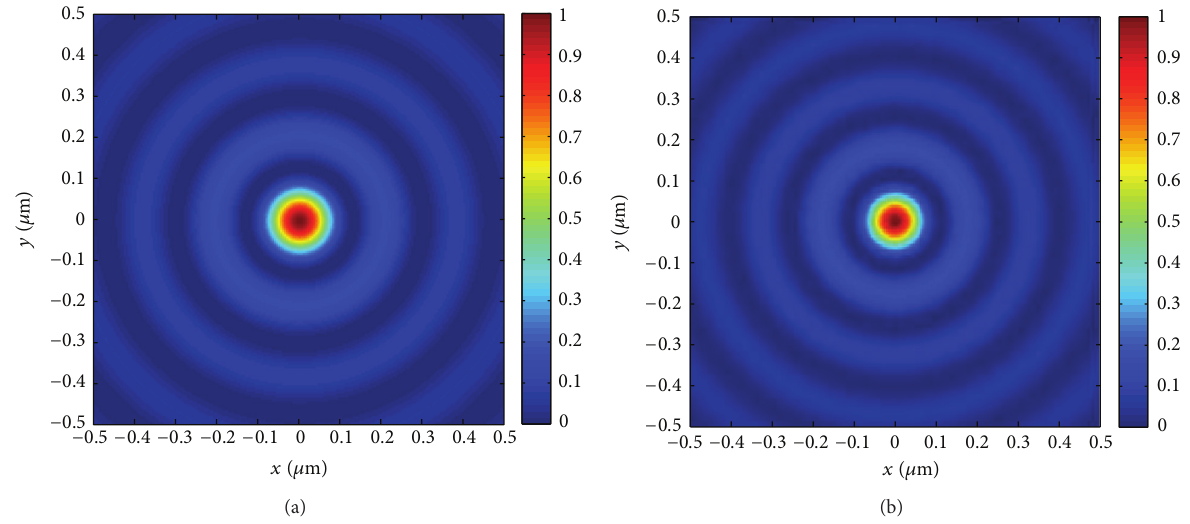
2 Figure 4: 2D pattern of normalized intensity distribution |𝐸 𝑙 2 | 2 /|𝐸 𝑙 2 | max for low- (a) and high-index (b) zero-order Bessel surface plasmon polaritons outside the gold layer of 50 nm thickness embedded in SF10 glass. BSPPs are generated by a purely radially polarized Bessel beam having a wavelength of 633 nm. The distance from the entrance surface of the metal layer is 𝑧 = 𝜆/3 .